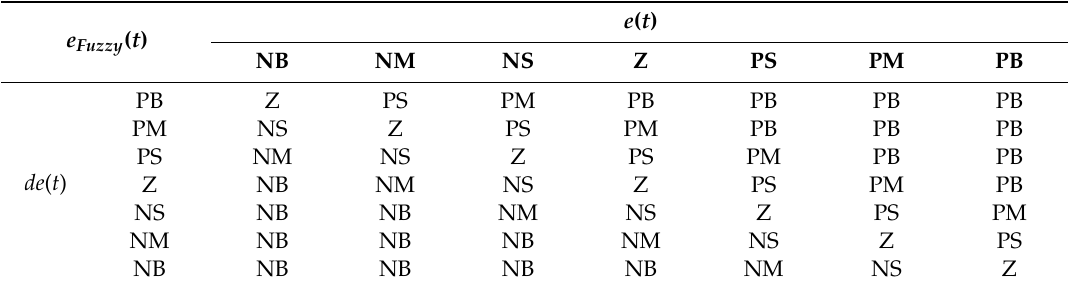
Figure 2. The fuzzification membership function. Table 1. Fuzzy rule-table. Table 1. Fuzzy rule-table.